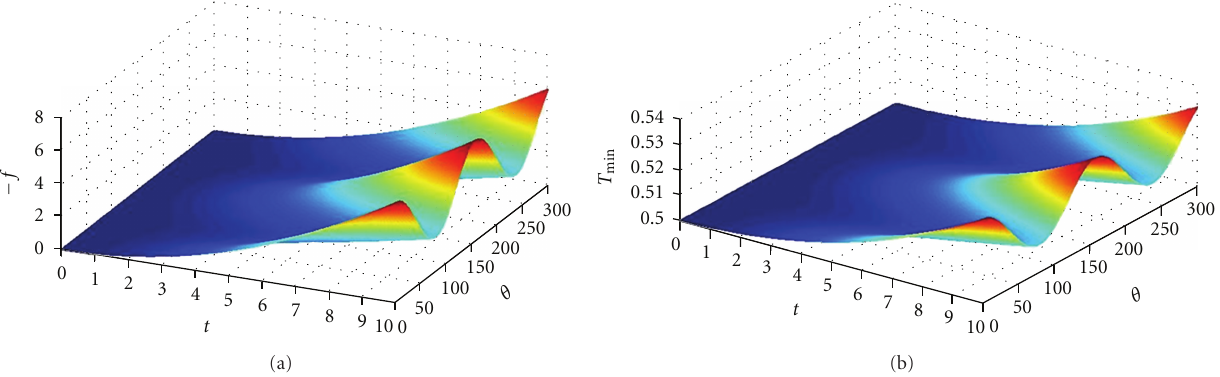
Figure 2: (a) Variation of − f for five-wave mixing process with respect to interaction time t and initial phase of the coherent state θ . (b) Variation of T min of five-wave mixing process with respect to interaction time t and initial phase of the coherent state θ